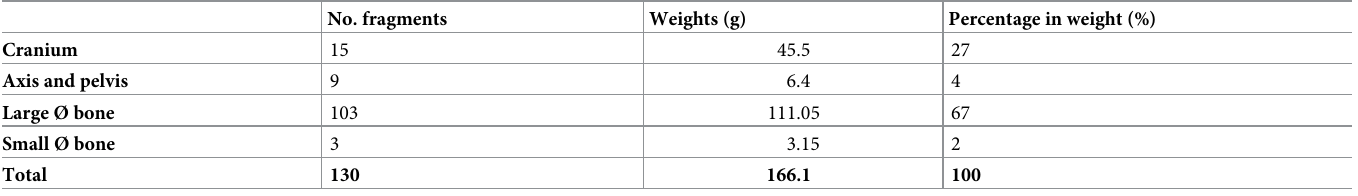
The number of fragments, weights, and percentage in weight of human cremated remains per main anatomical